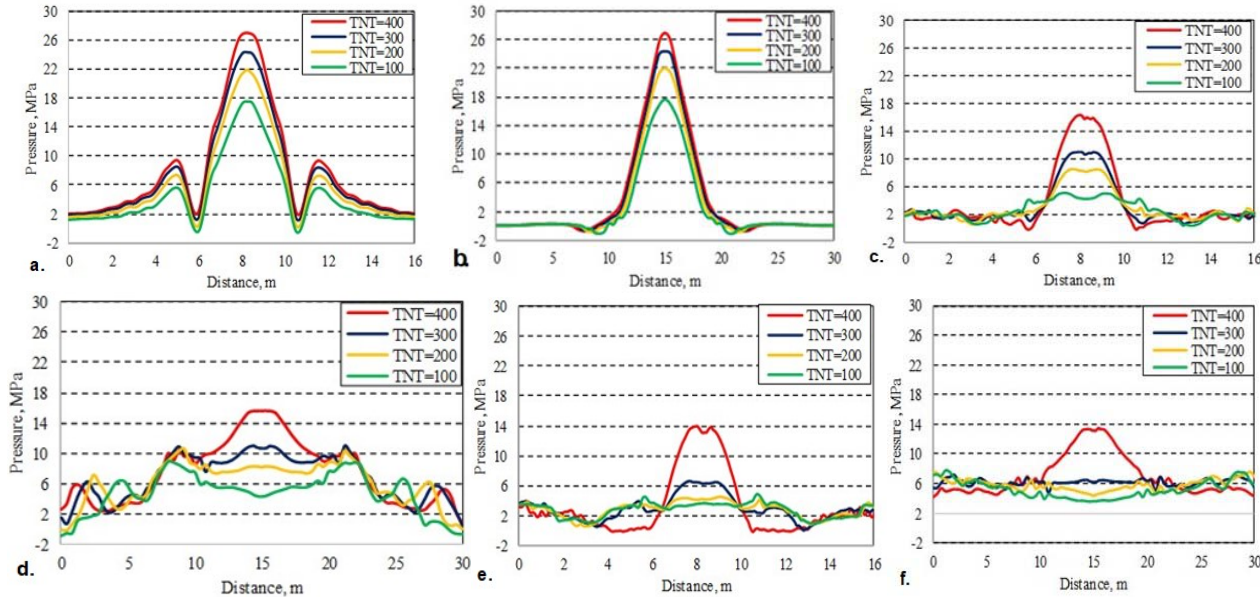
Figure 16: a. Pressure along Path 1 at 0.015 sec. b. Pressure along Path 2 at 0.015 sec. c. Pressure along Path 1 at 0.03 sec. d. Pressure along Path 2 at 0.03 sec. e. Pressure along Path 1 at 0.05 sec. f. Pressure along Path 2 at 0.05